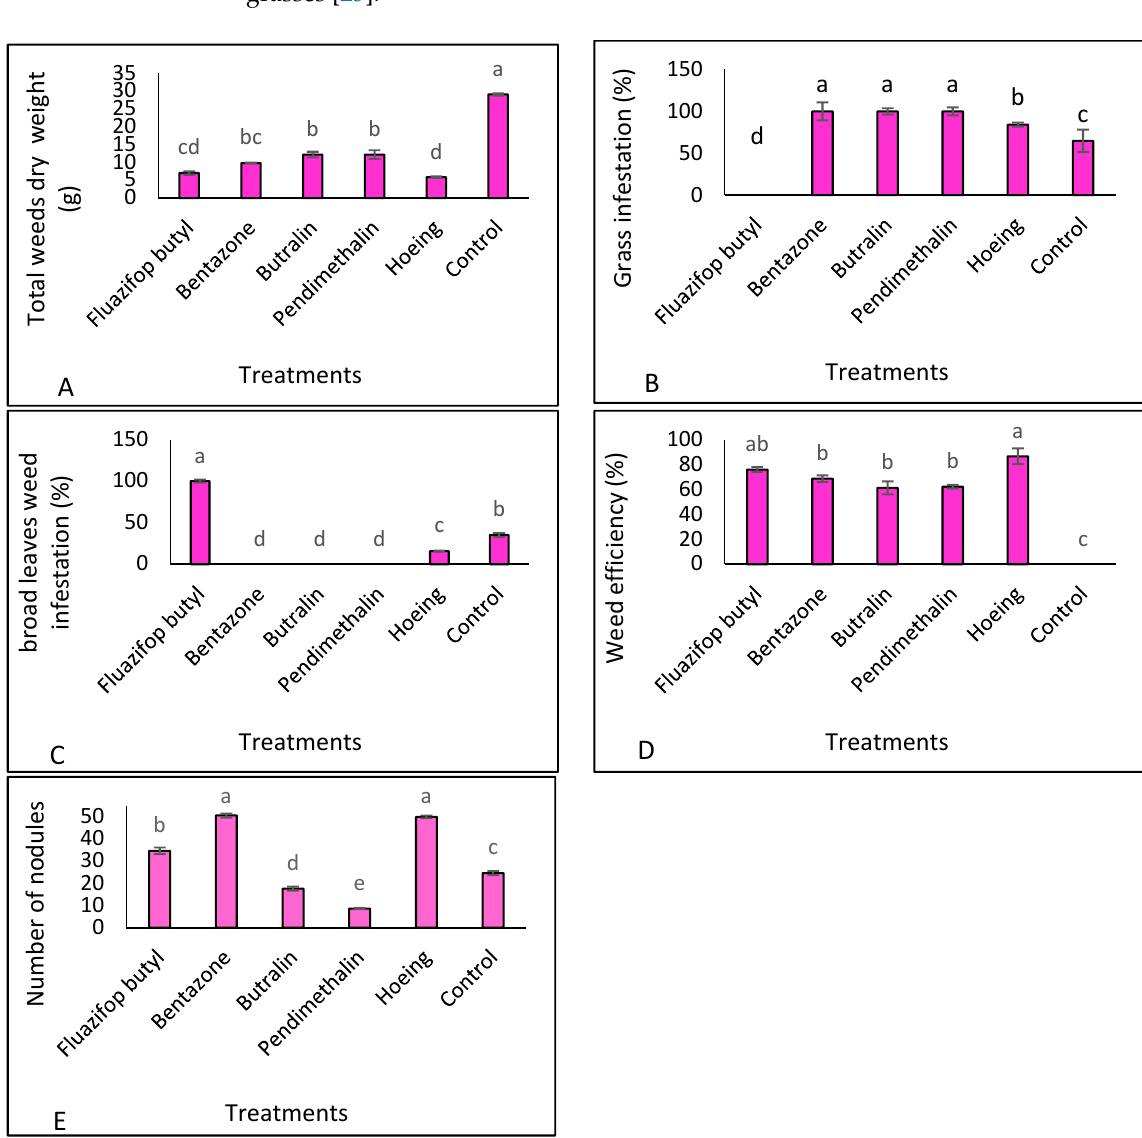
Figure 1. Effect of pre- and postemergence herbicides on total weed dry weight ( A ), grass infestation ( B ), broad leaf infestation ( C ), weed efficiency ( D ), and number of nodules ( E ). Different letters indicate significant differences between treatments (Duncan test at p < 0.05); vertical bars indicate standard error.